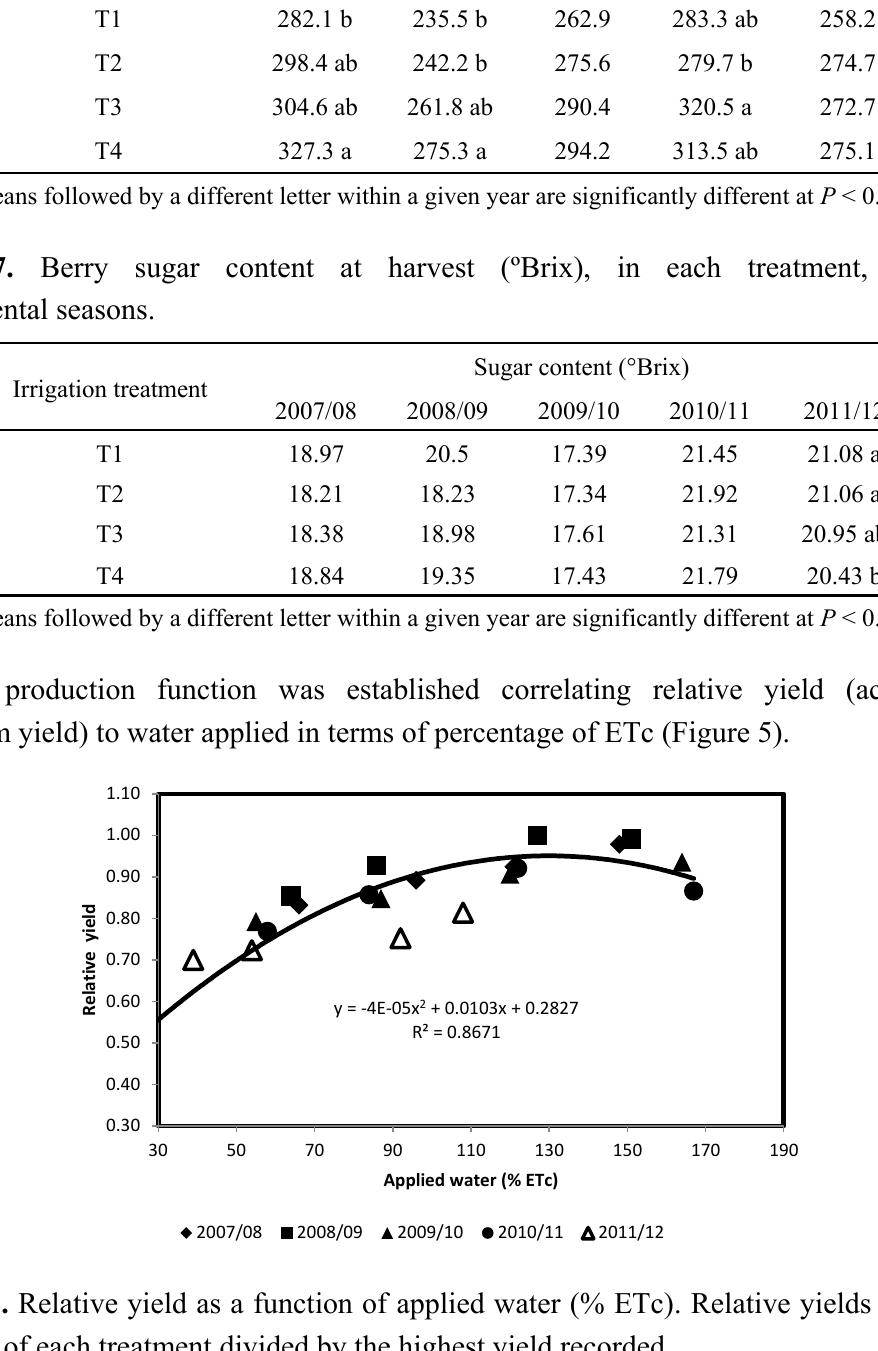
Table 6. Berry firmness at harvest (g mm −2 ) in each treatment, in five experimental years. Berry firmness (g/mm 2 ) Irrigation treatment